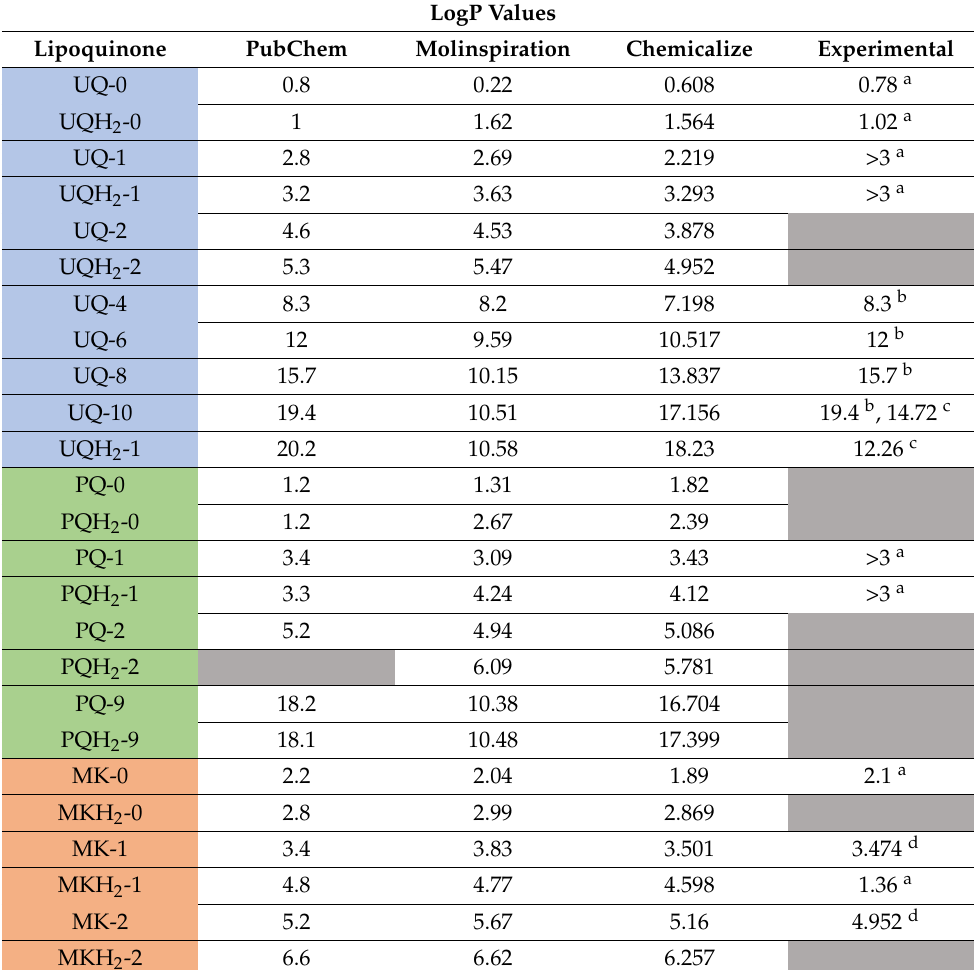
Table 2. LogP and clogP values of select lipoquinones from the literature. LogP Values Lipoquinone PubChem Molinspiration Chemicalize